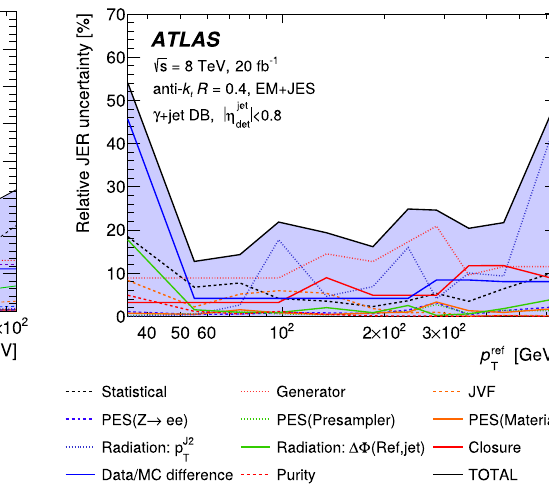
a shaded area, is obtained by addition in quadrature of all uncertainty components (including the data-to-MC difference). EES/EER denotes the electron energy scale/resolution, MMS/MMR denotes the muon momentum scale/resolution, and PES denotes the photon energy